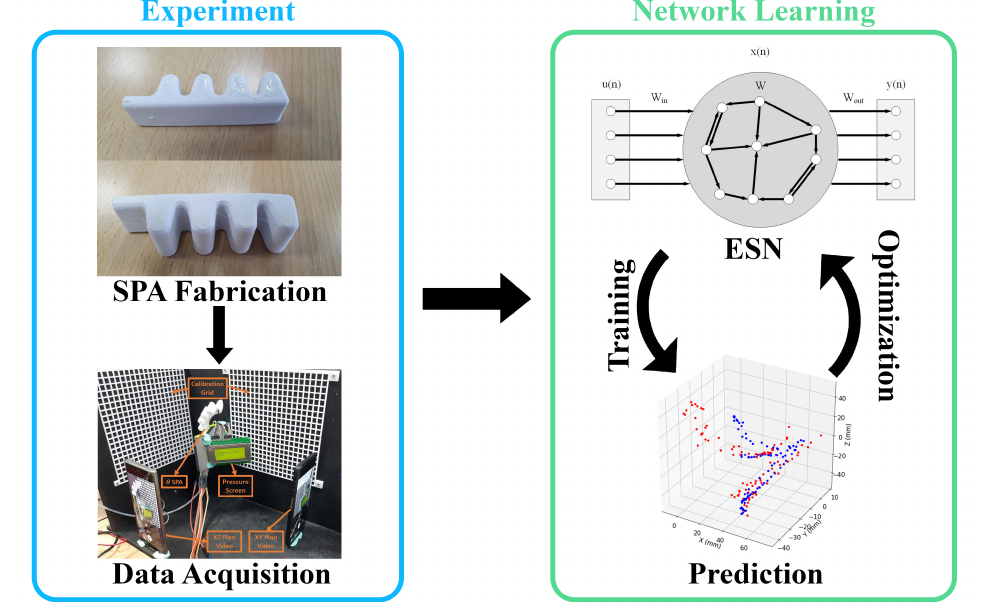
Figure 1. The pipeline for the modeling of the SPA using ESN. Ground truth data is obtained for different input actuation sequences of the SPA ( left ). The ESN learning process ( right ) is done in a cyclic manner. The network is first trained with fixed parameters, then the output weights are fixed and the parameters are optimized. The process is done iteratively till